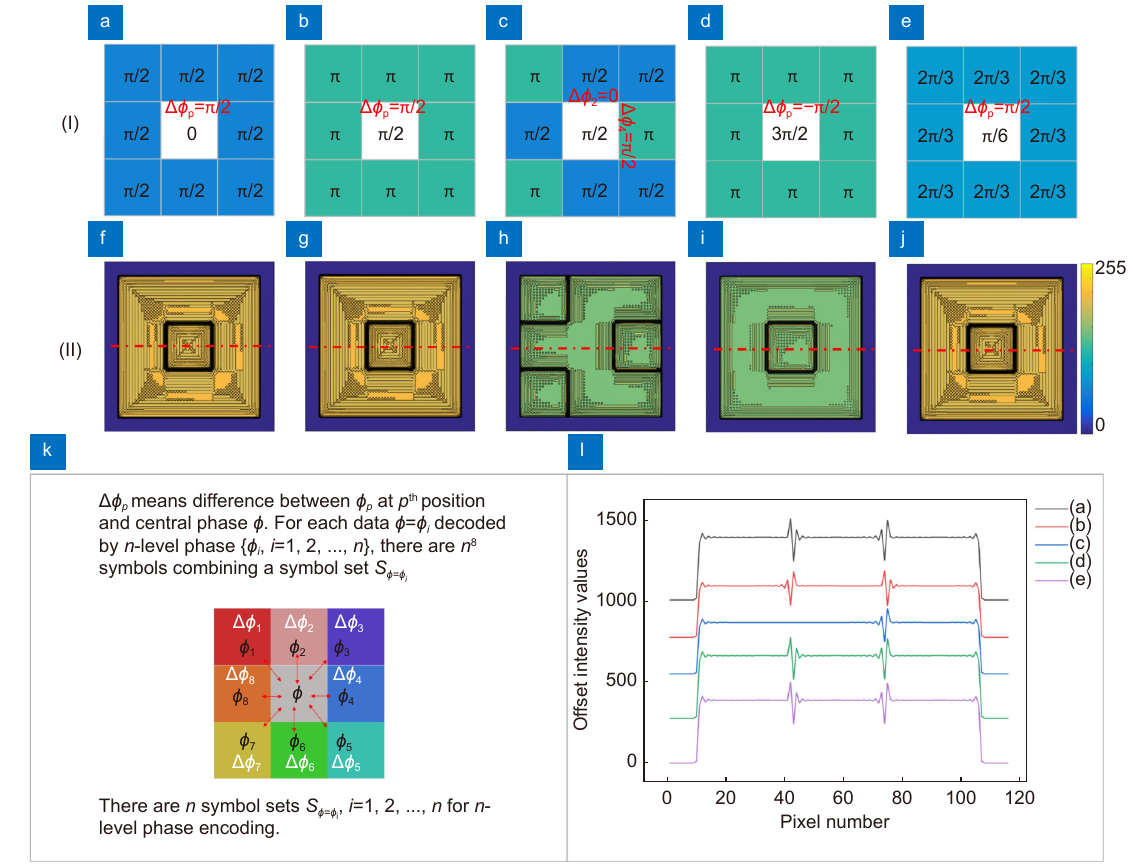
Fig. 5 | ( a – e ) Symbols with different phase patterns. ( f – j ) Diffraction intensity distributions corresponding to symbols (a)–(e). ( k ) General architec- ture of the symbol with 3×3 data points. ( l ) Intensity profile on the red line in intensity distribution